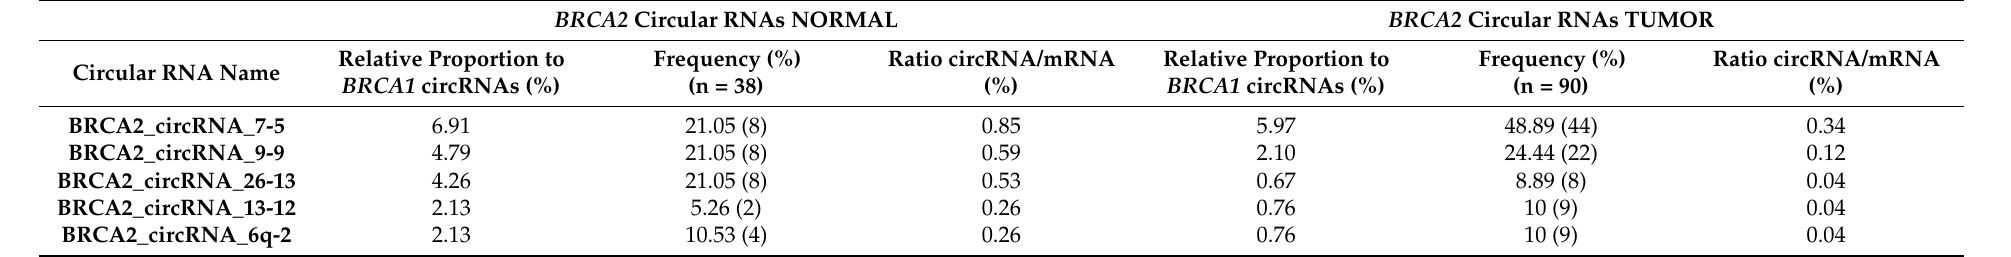
Table 4. Novel BRCA2 circular RNAs found in the normal and tumor breast tissue samples of the research set. BRCA2 Circular RNAs NORMAL BRCA2 Circular RNAs